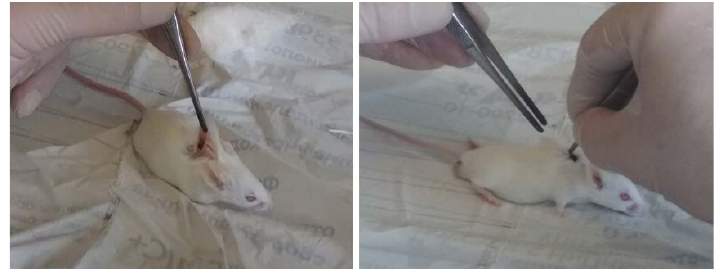
Figure 2. In vivo experiment design. Figure 1. Schematics of multiaxial deformation process ( a ) and the processing schedule ( b ).